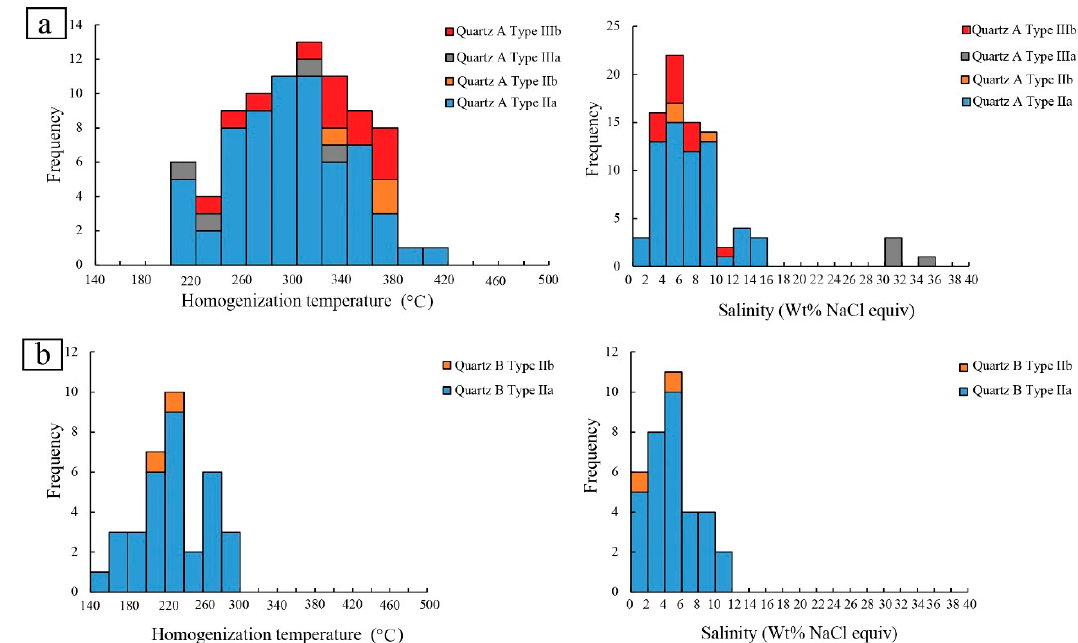
Figure 10. Histograms of homogenization temperature and salinity for all fluid inclusion types in the Nabeba deposit. ( a ) Fluid inclusion types in HO-1 stage; ( b ) Fluid inclusion types in HO-2 stage.